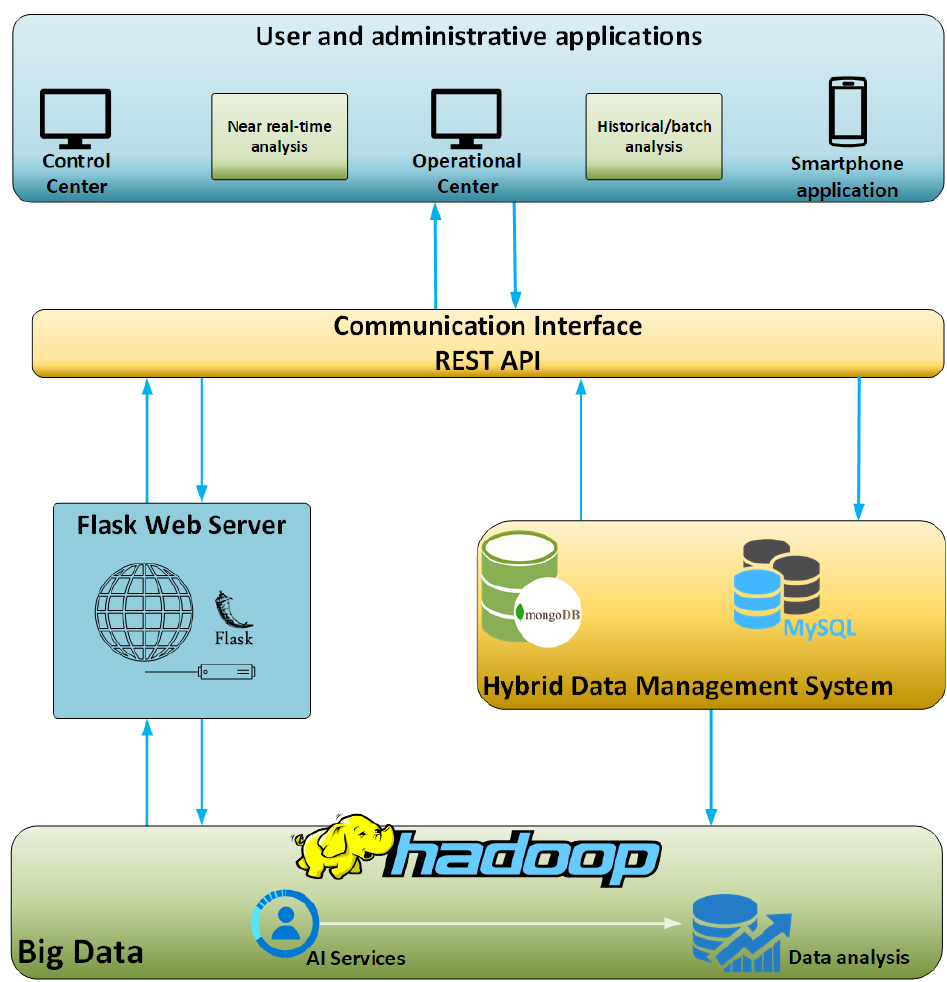
Figure 1. Hybrid data management and analysis platform.